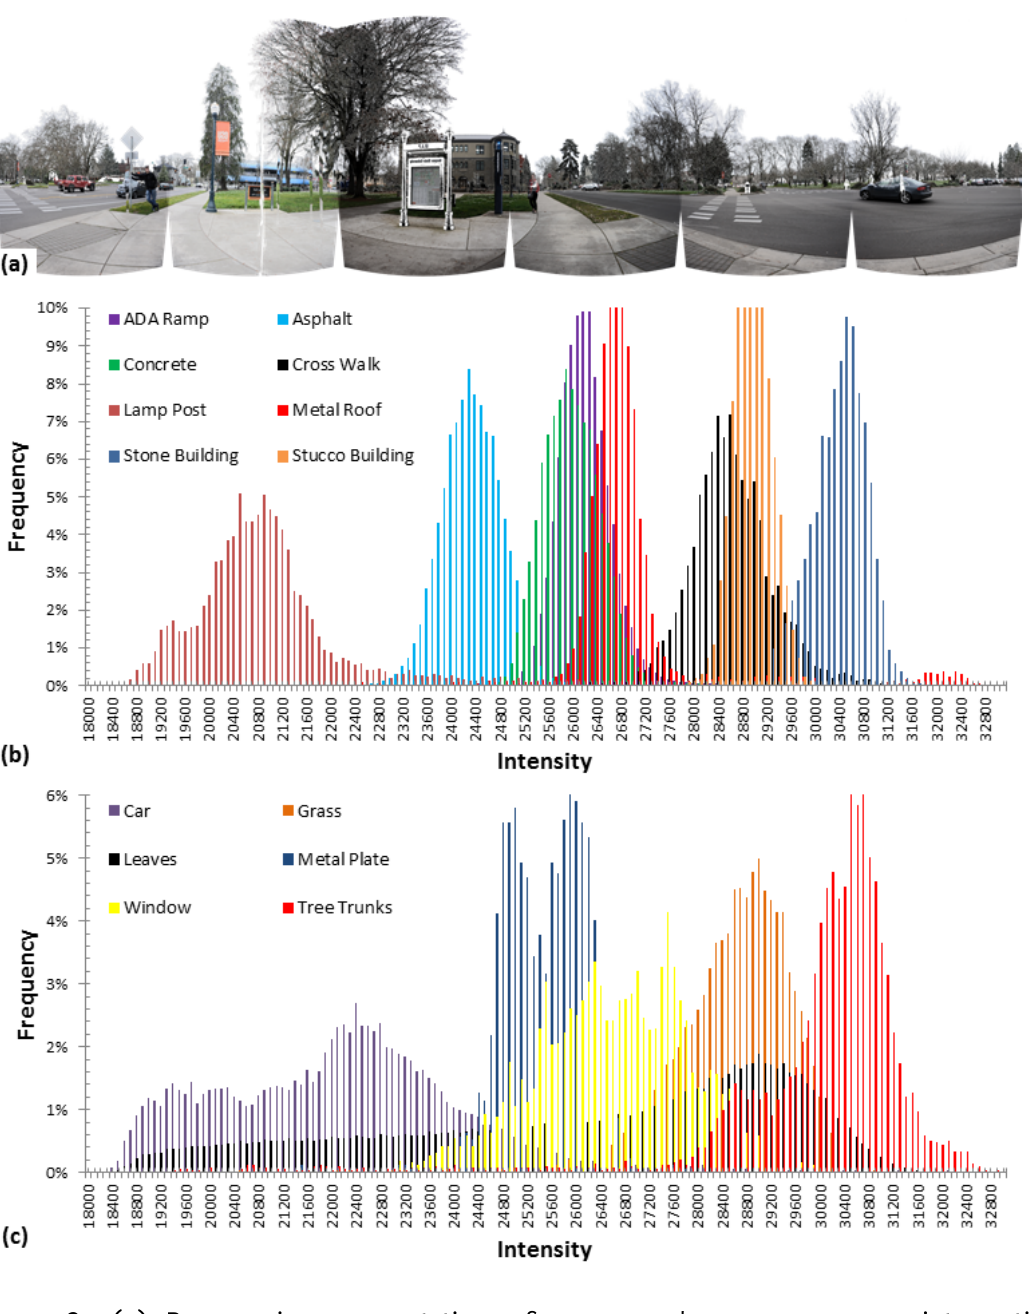
Figure 2. ( a ) Panoramic representation of a scanned scene near an intersection ( b , c ) histograms of intensity values measured on different